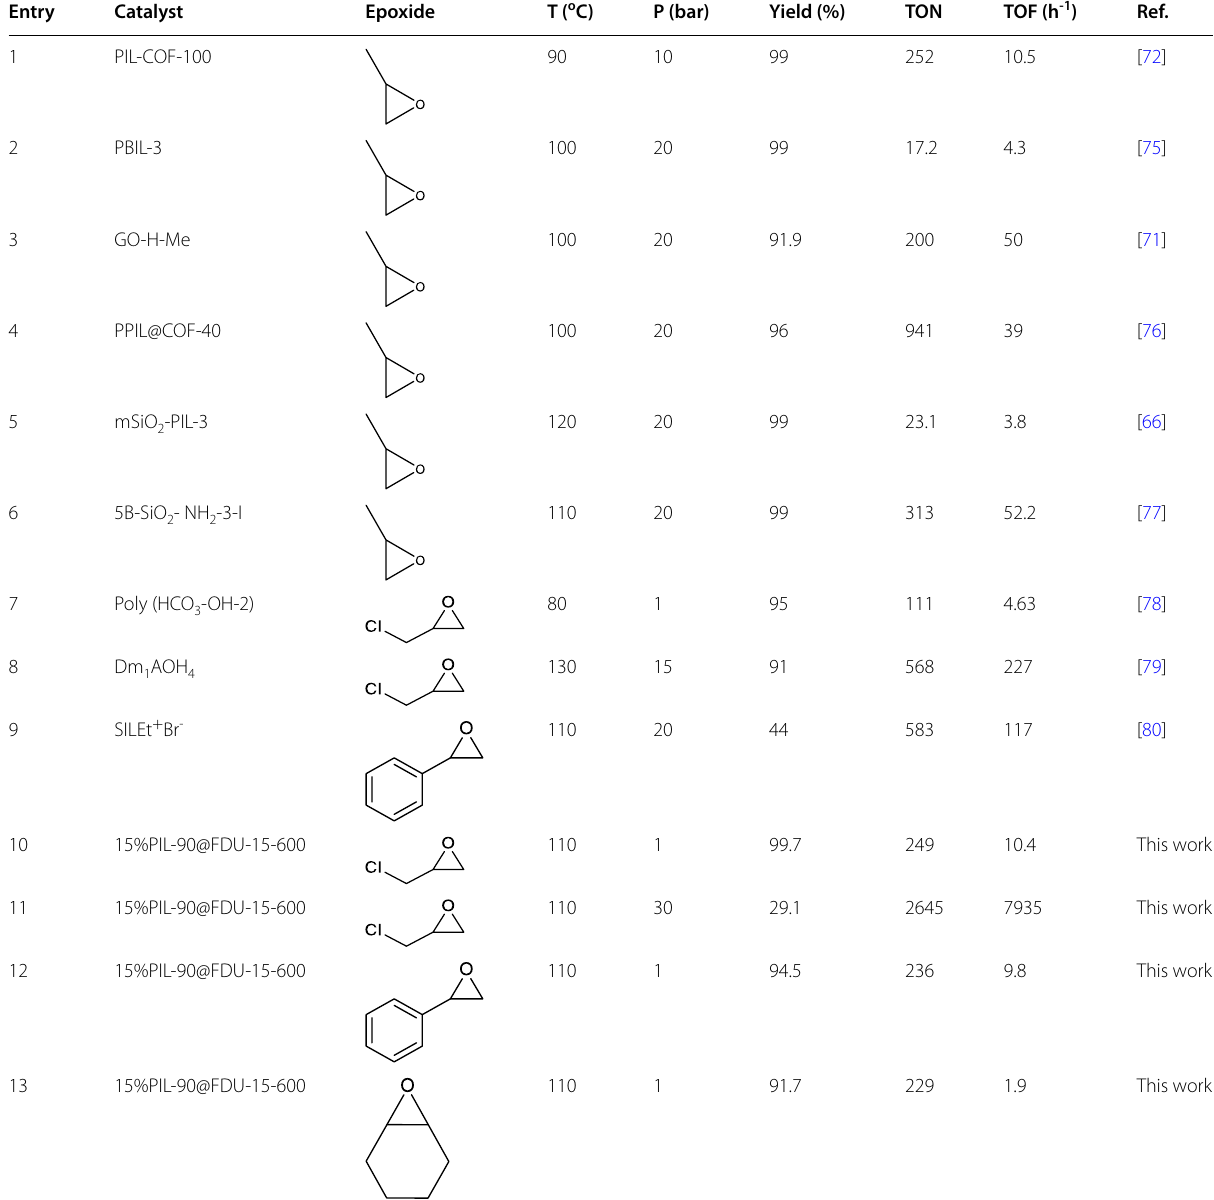
cycloaddition with 2